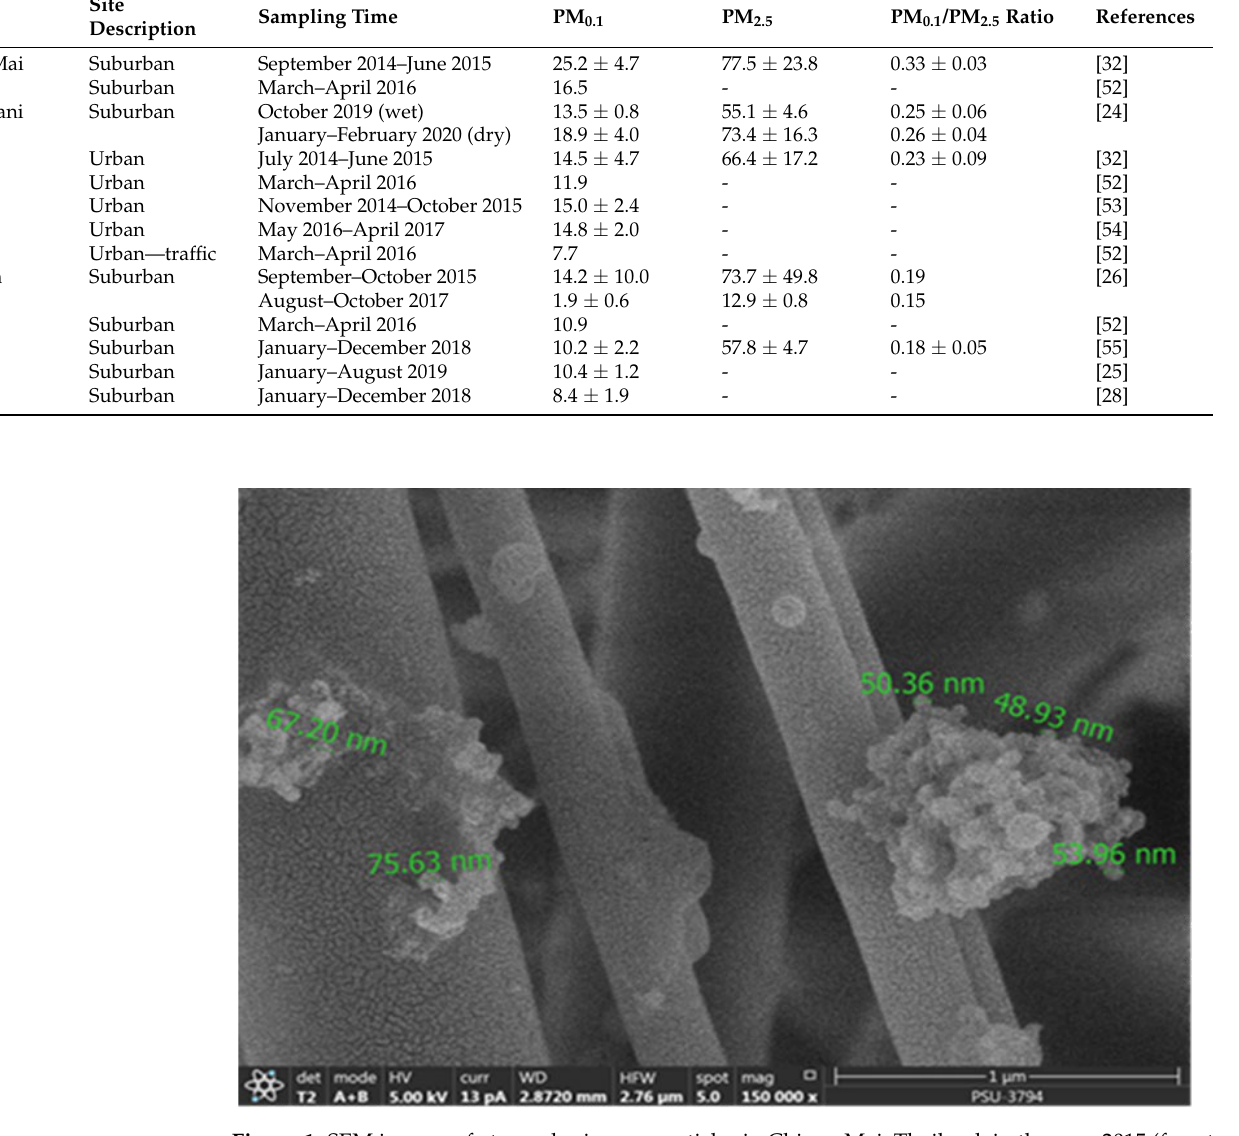
Figure 1. SEM images of atmospheric nanoparticles in Chiang Mai, Thailand, in the year 2015 (forest fires dominated as emission sources during the dry season) [2].